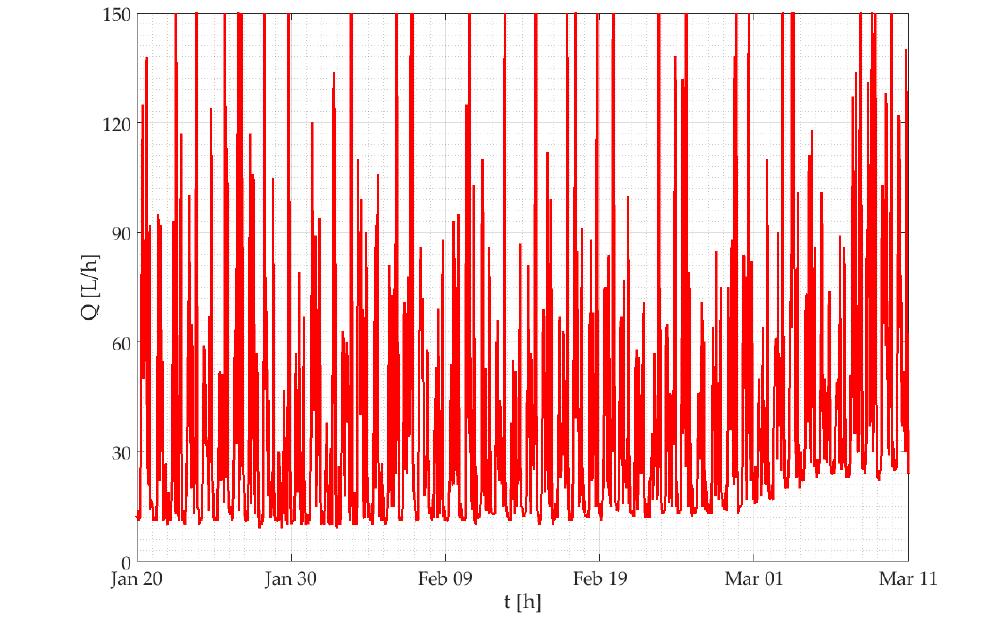
Figure 8. Hourly incremental consumption trends of a user affected by a large leak.